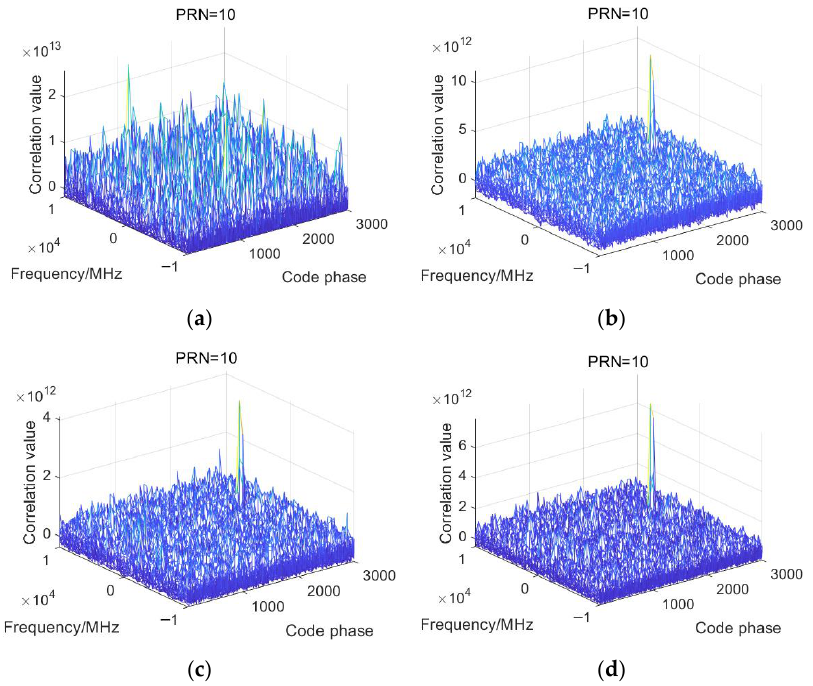
Figure 8. SIR =−34 dB, acquisition effect of the four algorithms: ( a ) coherent integration; ( b ) coherent and non-coherent integration; ( c ) differential coherent integration; and ( d ) improved differential coherent integration.